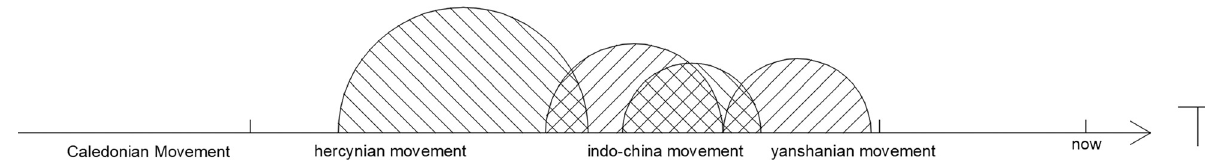
Figure 8: Matching diagram of tectonic movement and petroleum